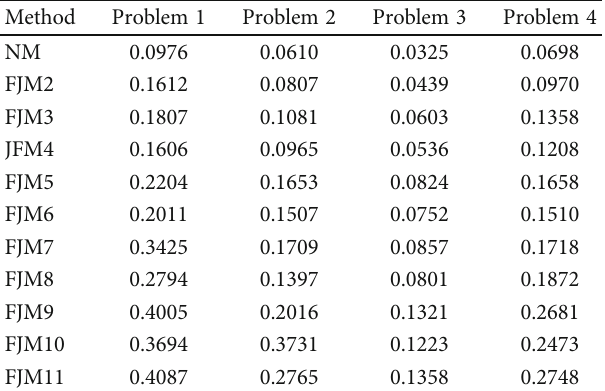
Table 10: Values of FJC2 for case n = 100 .